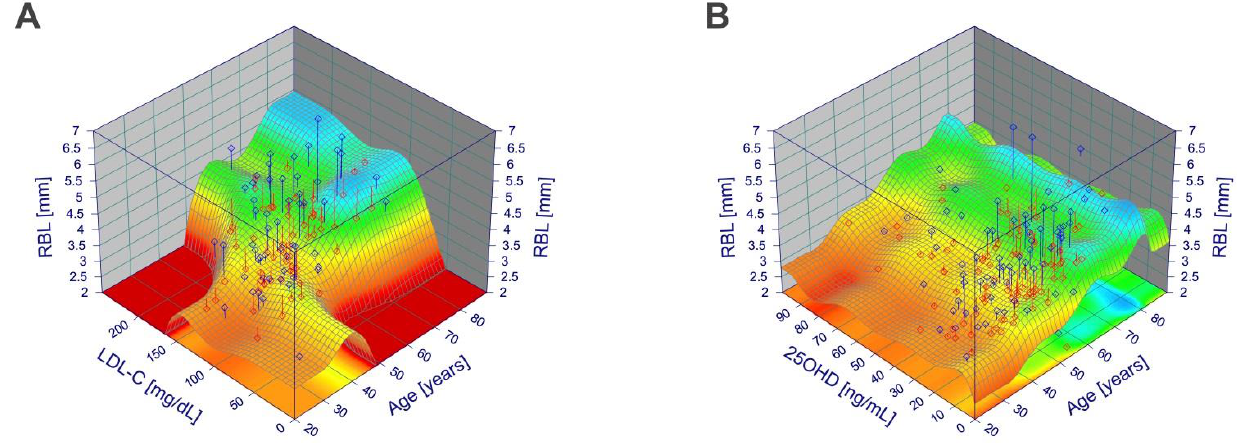
Figure 6. Influence of age and LDL-C or 25OHD levels, respectively, on RBL as fitted three-dimensional curves. ( A ) Influence of age and LDL-C level on RBL as fitted three-dimensional curve (Cosine Series Bivariate Order 5; r 2 = 0.44). ( B ) Influence of age and 25OHD level on RBL as fitted three-dimensional curve (Fourier Series Simple Order 2 × 4; r 2 = 0.37).